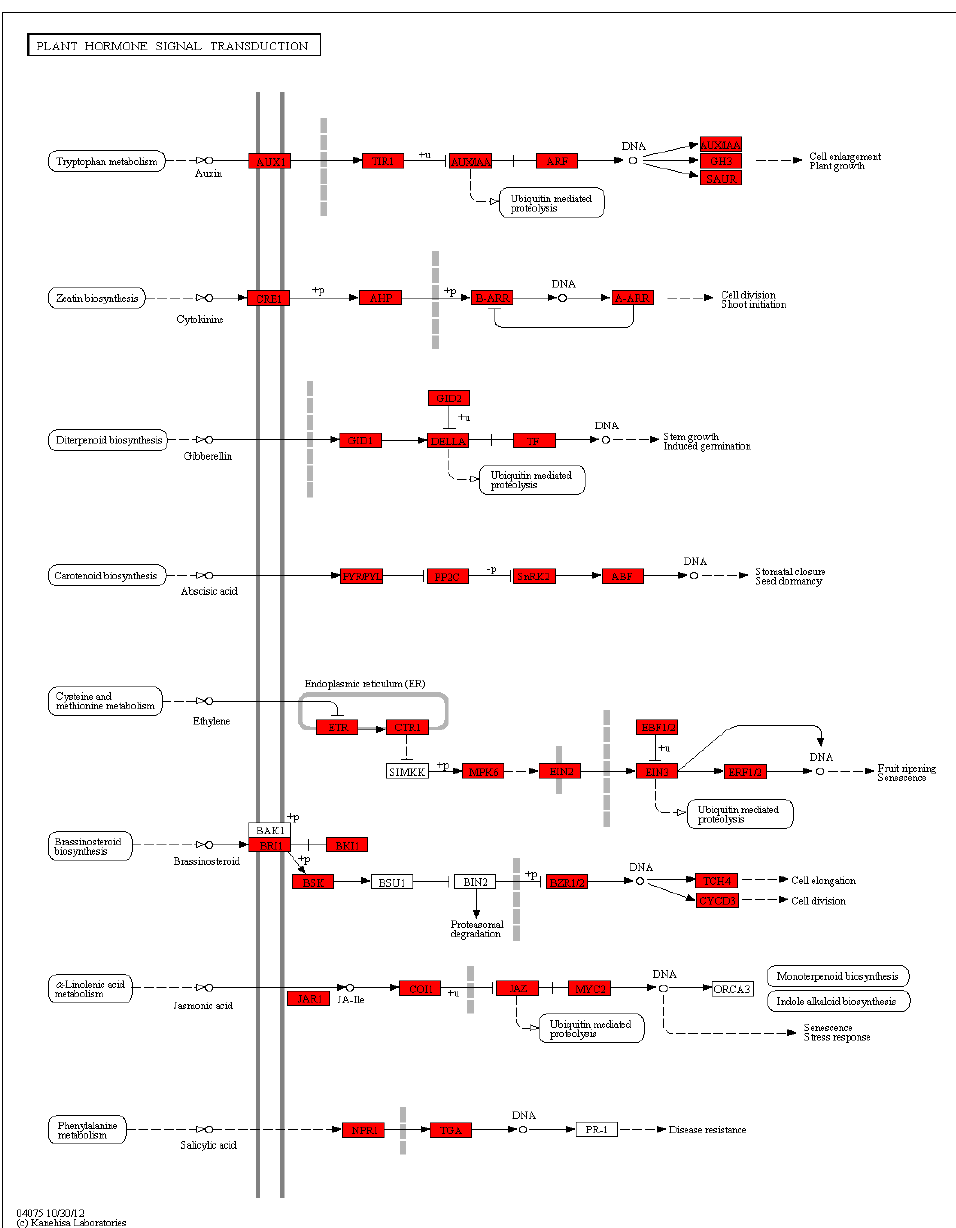
Figure 23. Plant hormone signal transduction pathway. The red boxes indicate Unigenes were assigned to the metabolic pathways.